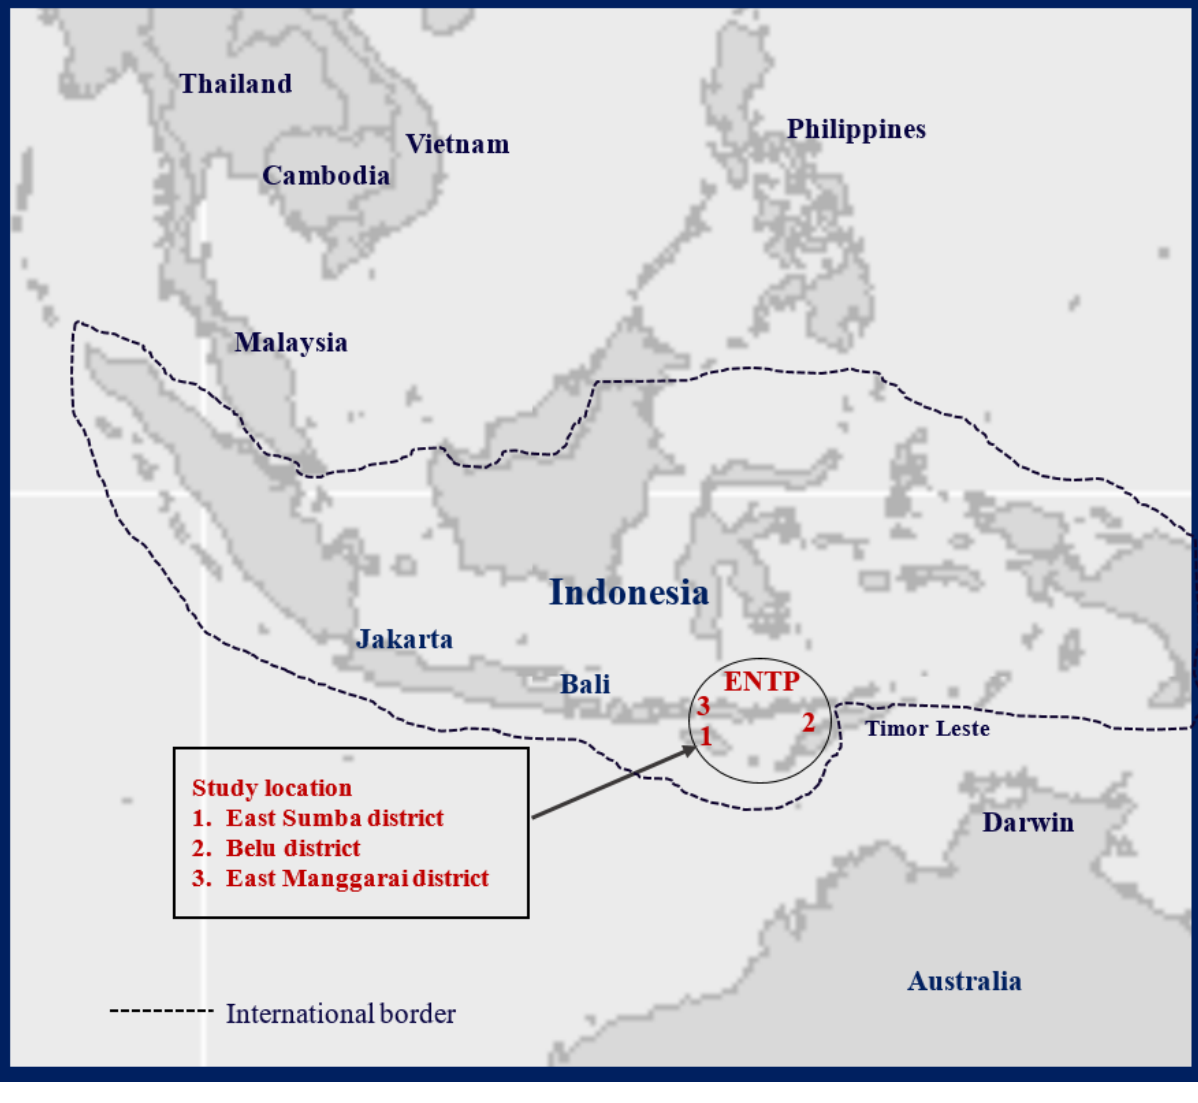
Figure 1. Map of study sites. ENTP: East Nusa Tenggara